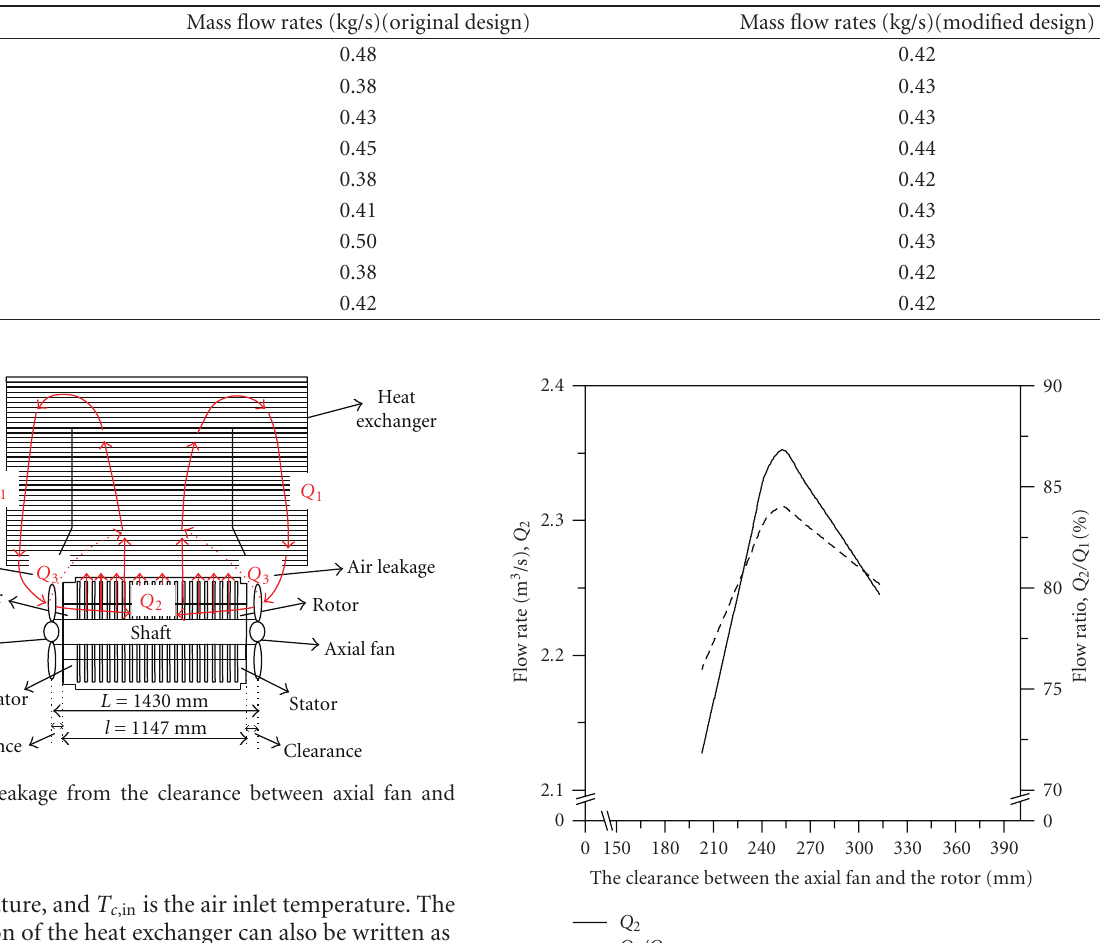
Table 2: Mass flow rates for the external flow under di ff erent block numbers.